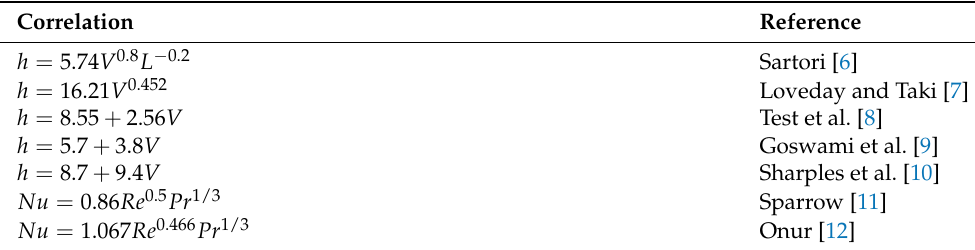
Table 1. Reported PV flat plate heat transfer coefficient ( h ) and Nusselt number correlations. V is wind speed in